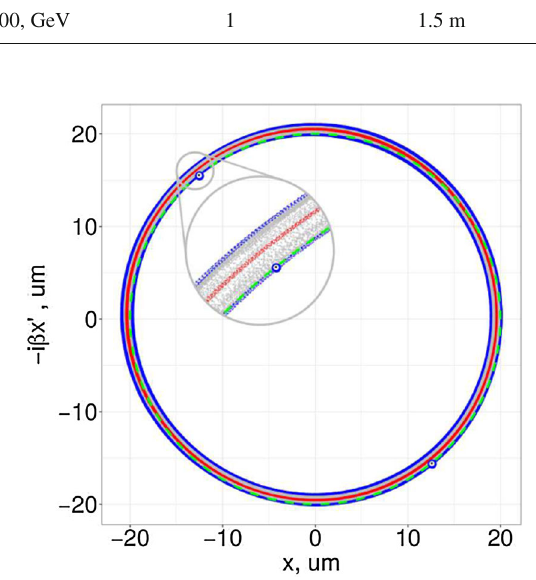
Fig. 4 The trajectories of the particles with r x = 20, r y = 30 µ m in z x projection for the bunches separated in x by 40 µ m with the parameters from Table 1 as an example. The outer blue trajectories are formed by two initially opposite particles (marked by small open circles) after the instantaneous switch of the beam–beam force. The grey band between them is composed of such trajectories from all particles. The adiabatic trajectory is in red and the initial circle with r x = 20 µ m is shown by the green dashed line